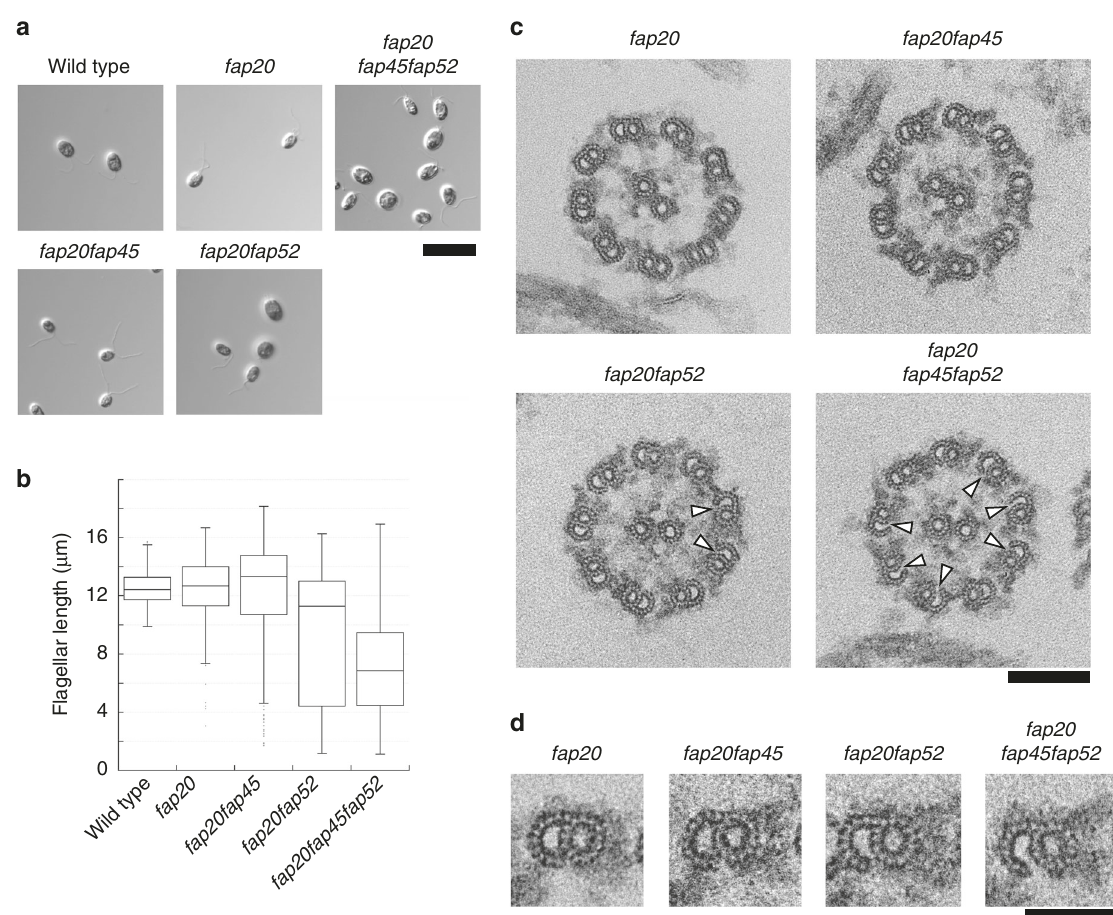
Fig. 6 MIP3a is important for B-tubule anchoring to the A-tubule at inner junctions. a Differential interference contrast (DIC) images of wild type, fap20 , fap20fap45, fap20fap52 , and fap20fap45fap52 cells. Scale bar = 10 μ m. b Box and whisker plots of fl agellar length in wild type, fap20 , fap20fap45 , and fap20fap52 . fap20fap52 and fap20fap45fap52 fl agella were signi fi cantly shorter than in wild type, fap20 , and fap20fap45 . The whiskers represent 95% con fi dence intervals. The box represents the interquartile range and the center line shows the median. c Cross-sectional EM images of fap20, fap20fap45, fap20fap52 , and fap20fap45fap52 axonemes. Arrowheads indicate disconnections between the A-tubule and B-tubule. Scale bar = 100 nm. d Cross- sectional images of fap20 , fap20fap45 , fap20fap52 , and fap20fap45fap52 DMTs. Scale bar = 50